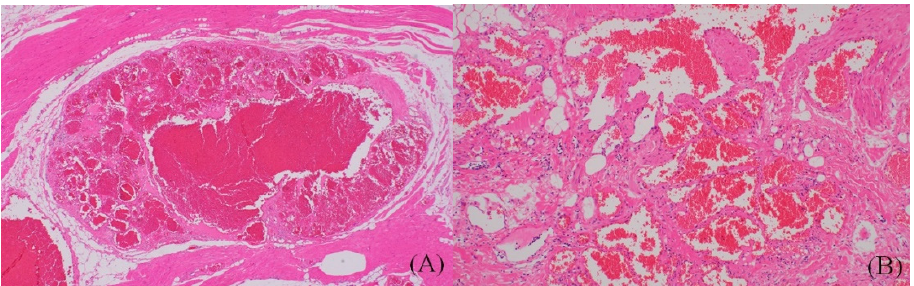
Figure 4. ( A ) Upon low-power examination, dilated vascular structures were noted in the skeletal muscle and fat tissue (hematoxylin and eosin stain, ×40). ( B ) The cavernous-like vascular spaces had variable sized walls and were filled with blood (hematoxylin and eosin stain, ×200).